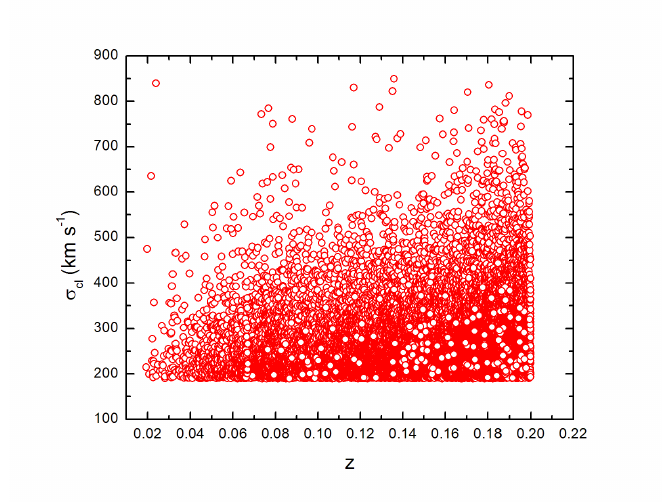
Fig. 1 σ cl - redshift